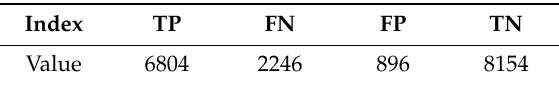
Table 5. Forecast index value.